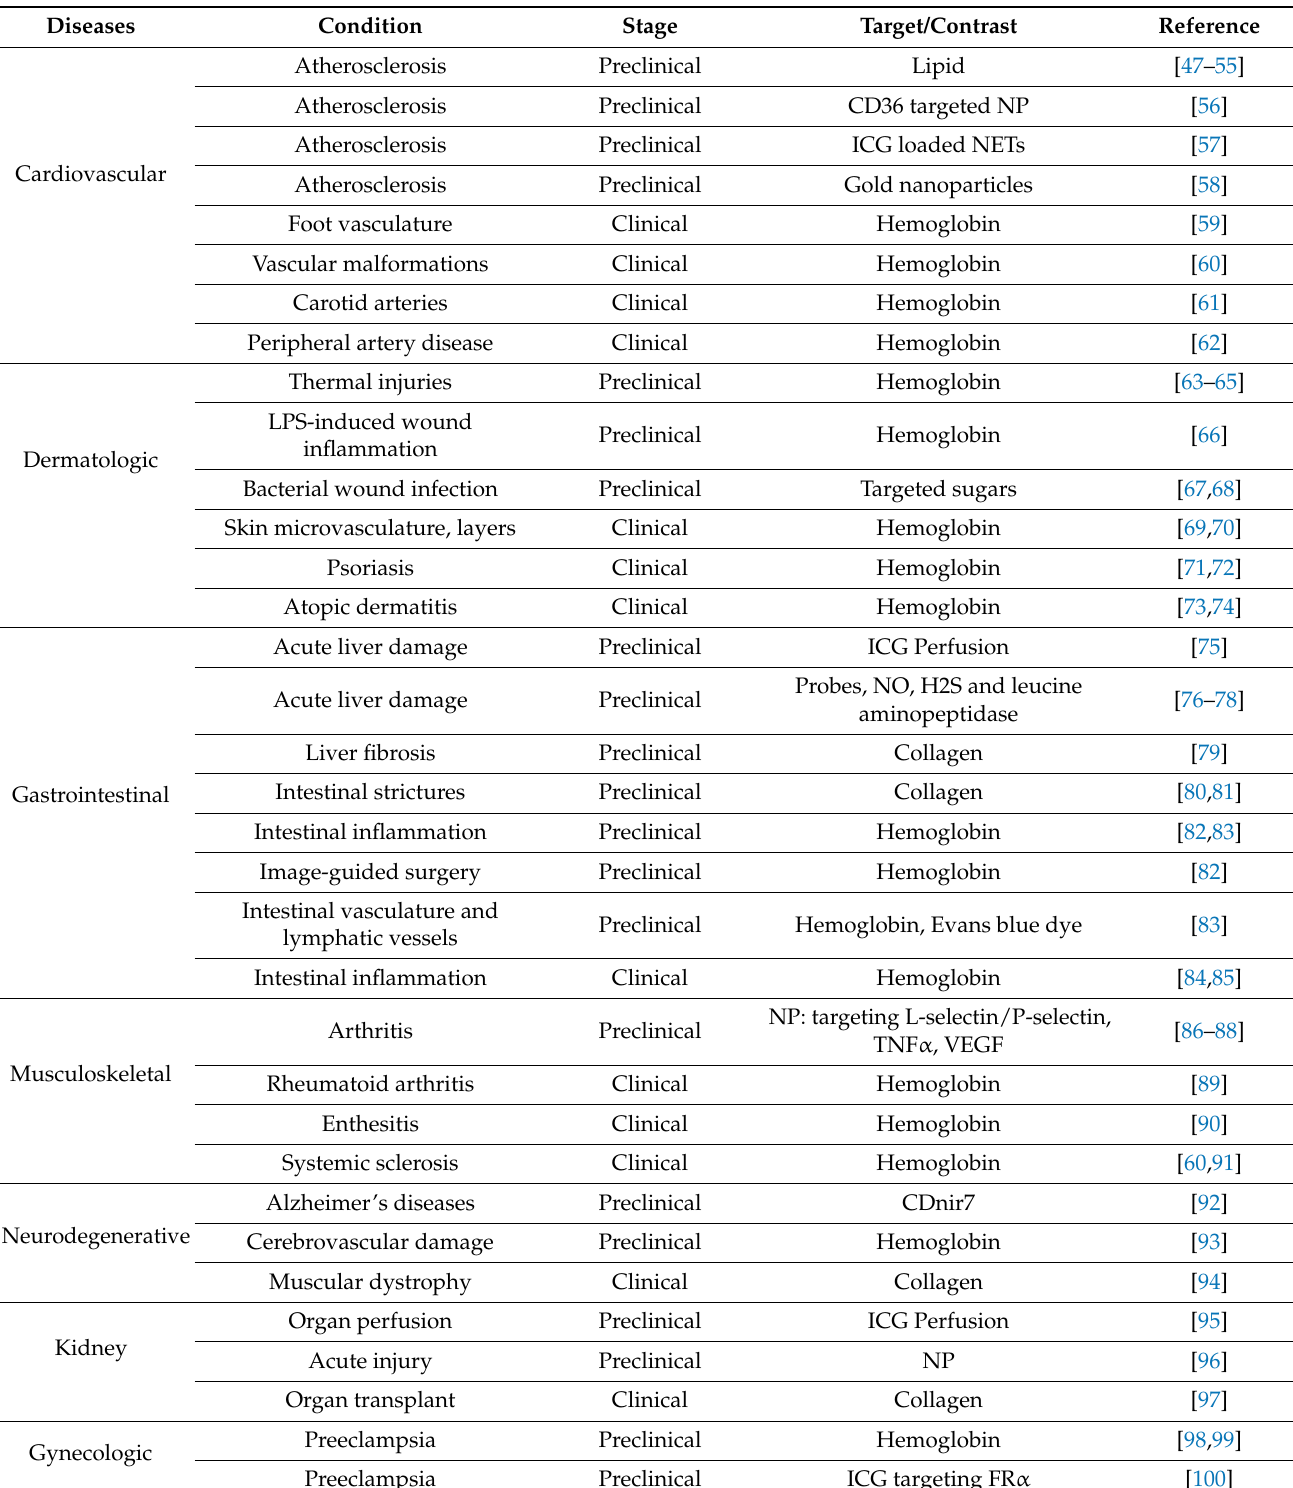
Table 2. Selected inflammatory diseases studied with OAI. ICG = indocyanine green, NET = near-infrared erythrocyte- derived transducers, NP = nanoparticle, VEGF = Vascular endothelial growth factor, TNF α = tumor necrosis factor- α .